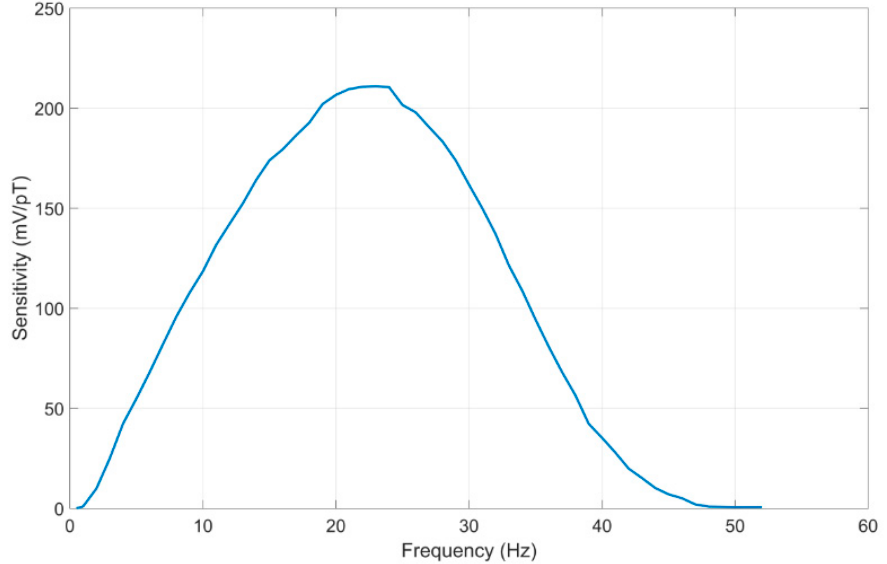
Figure 9. Total measured amplification and filtering circuit gain vs. frequency.